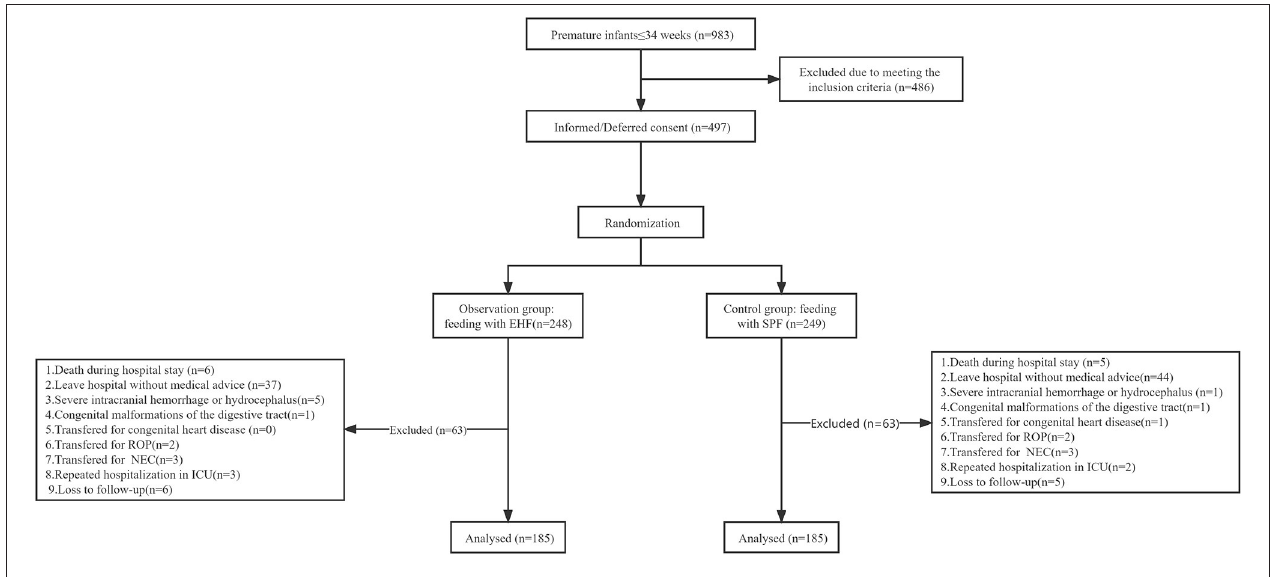
FIGURE 1 | Study enrollment flow diagram.